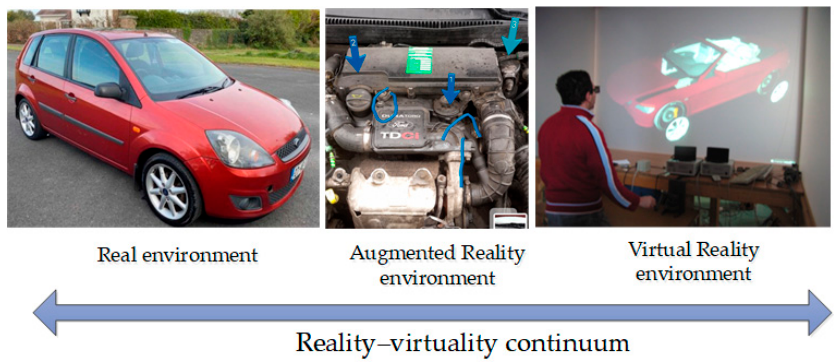
Figure 1. Adapted Milgram’s reality ‒ virtuality continuum for the automotive industry.